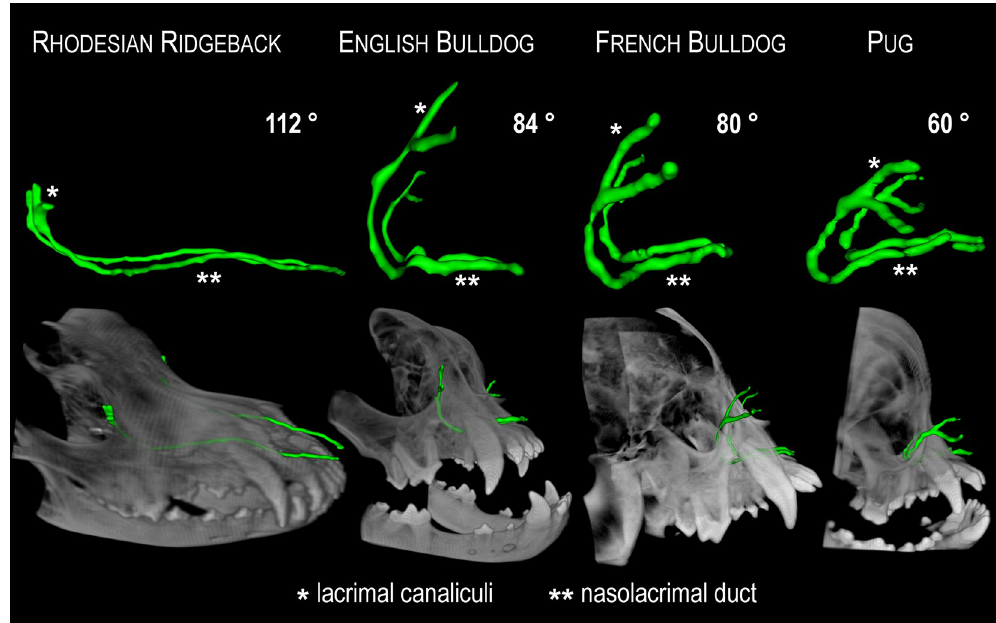
Fig 7. The different shapes of the tear drainage system (NDS) in normocephalic and brachycephalic dog breeds. The contrast-filled bilateral NDS, viewed from the side, is shown in green. At the top of the picture, it is shown outside its bony environment, while below it appears inside the skull. The given degrees reflect the angulation of the NDS. The NDS in normocephalic breeds has an obtuse-angled character, while brachycephalic dogs exhibit an acute-angled NDS, with the Pug showing the smallest values. These values support the depicted inversely directed course of the initial parts of the NDS in brachycephalic dog breeds. The very small angle in Pugs shows that the NDS is severely compressed in the vertical plane, with the lacrimal canaliculi and end portion of the nasolacrimal duct moving towards each other. In the lateral view, the characteristic shape of the NDS resembles the letter L in normocephalic and a U in brachycephalic dogs. In the case of a Pug, the compressed, clearly acute-angled appearance is more like a V than a U. Also noteworthy are the very long lacrimal canaliculi in brachycephalic dogs compared to the Rhodesian Ridgeback.